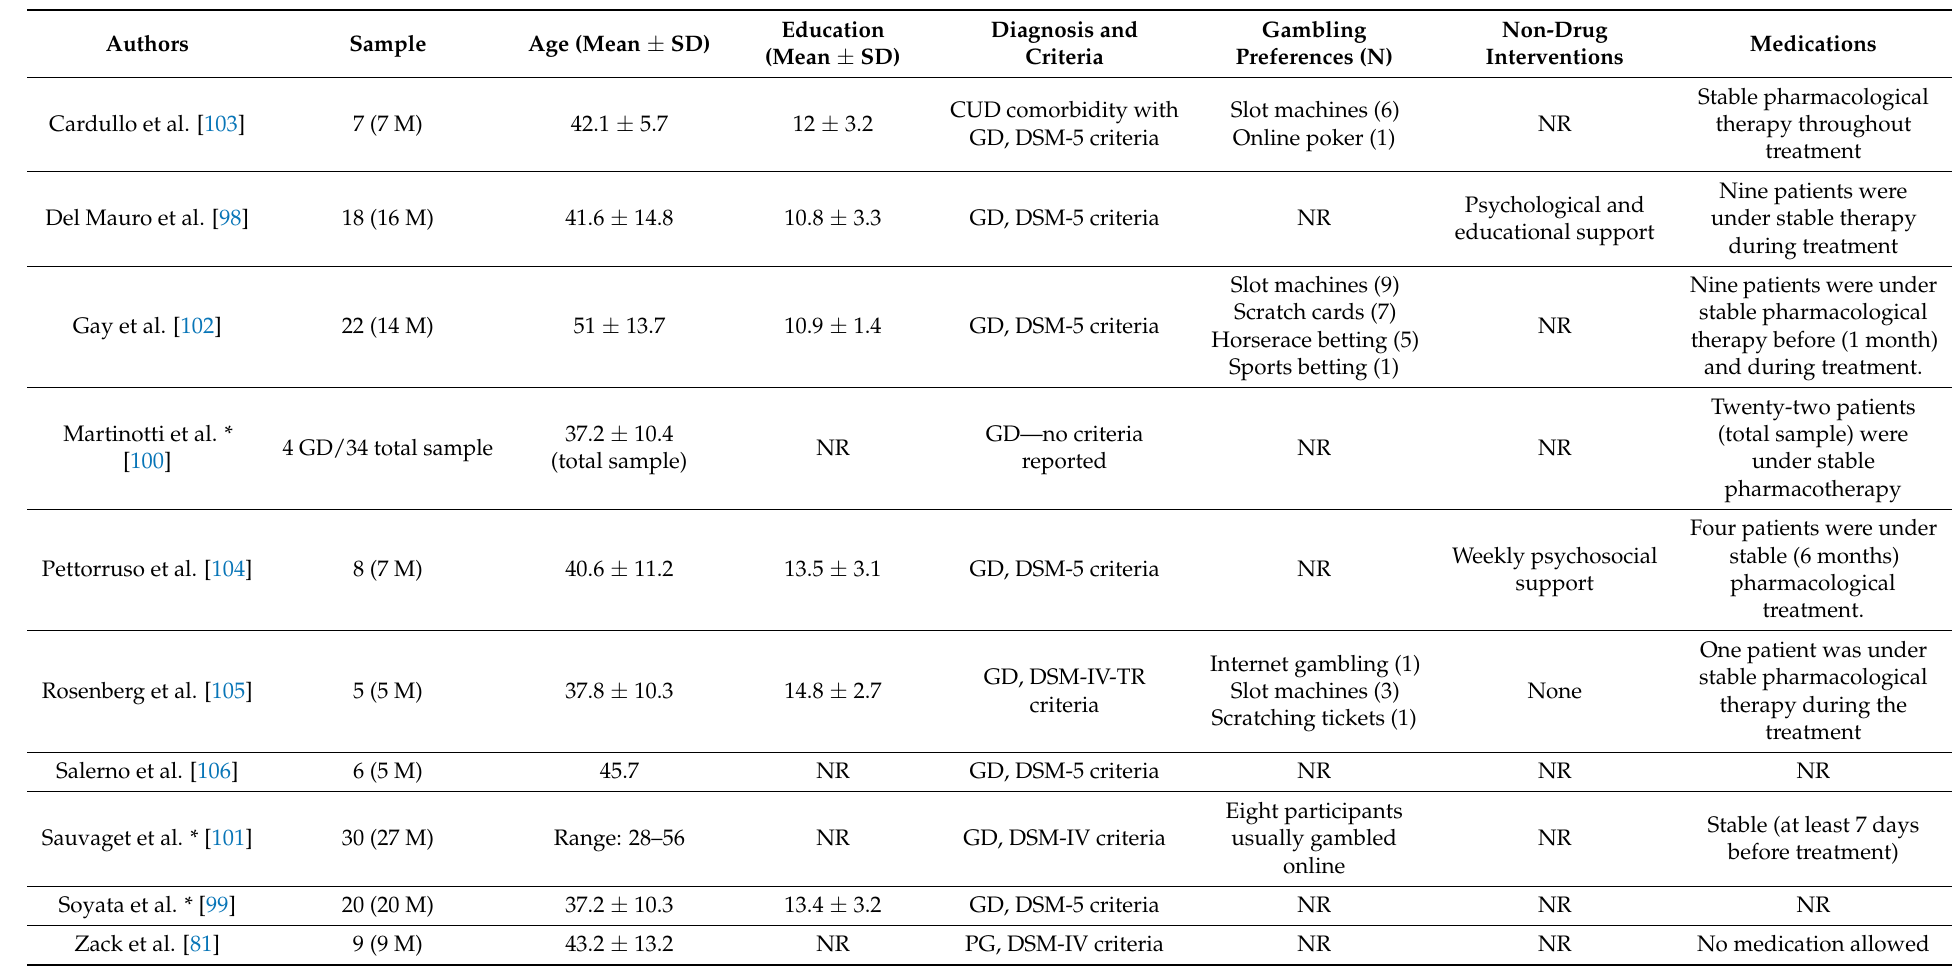
Table 3. Descriptive information of patients’